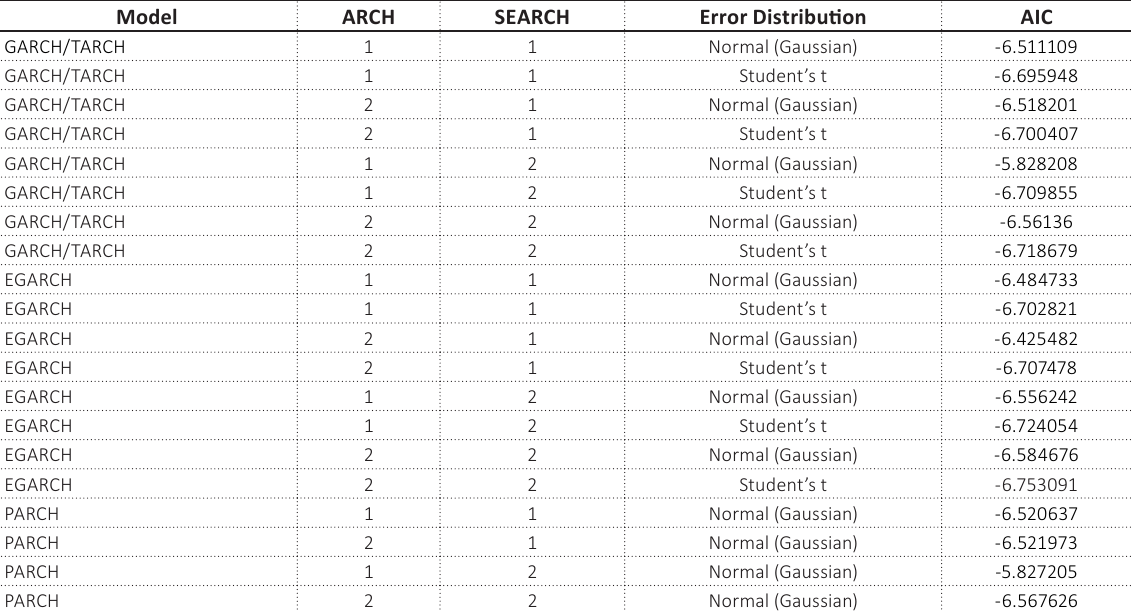
Table 2. Selecting the model with the best fit Model